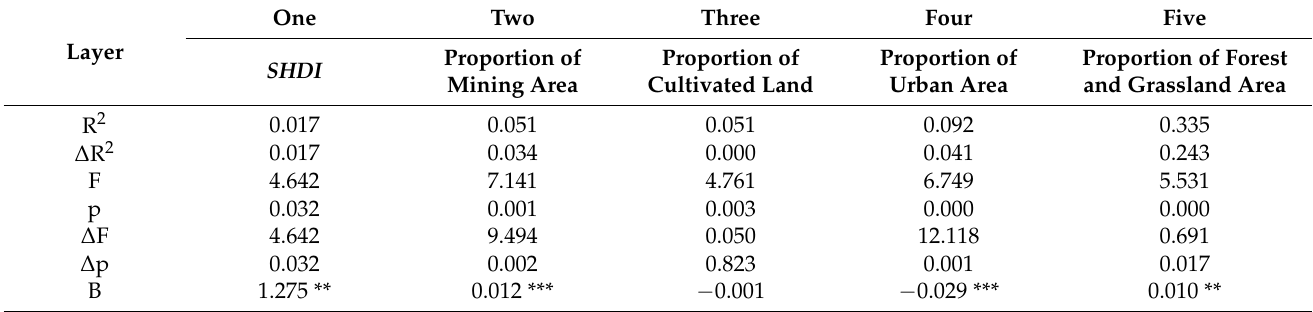
Table 5. The results of hierarchical multiple regression of the SCF.